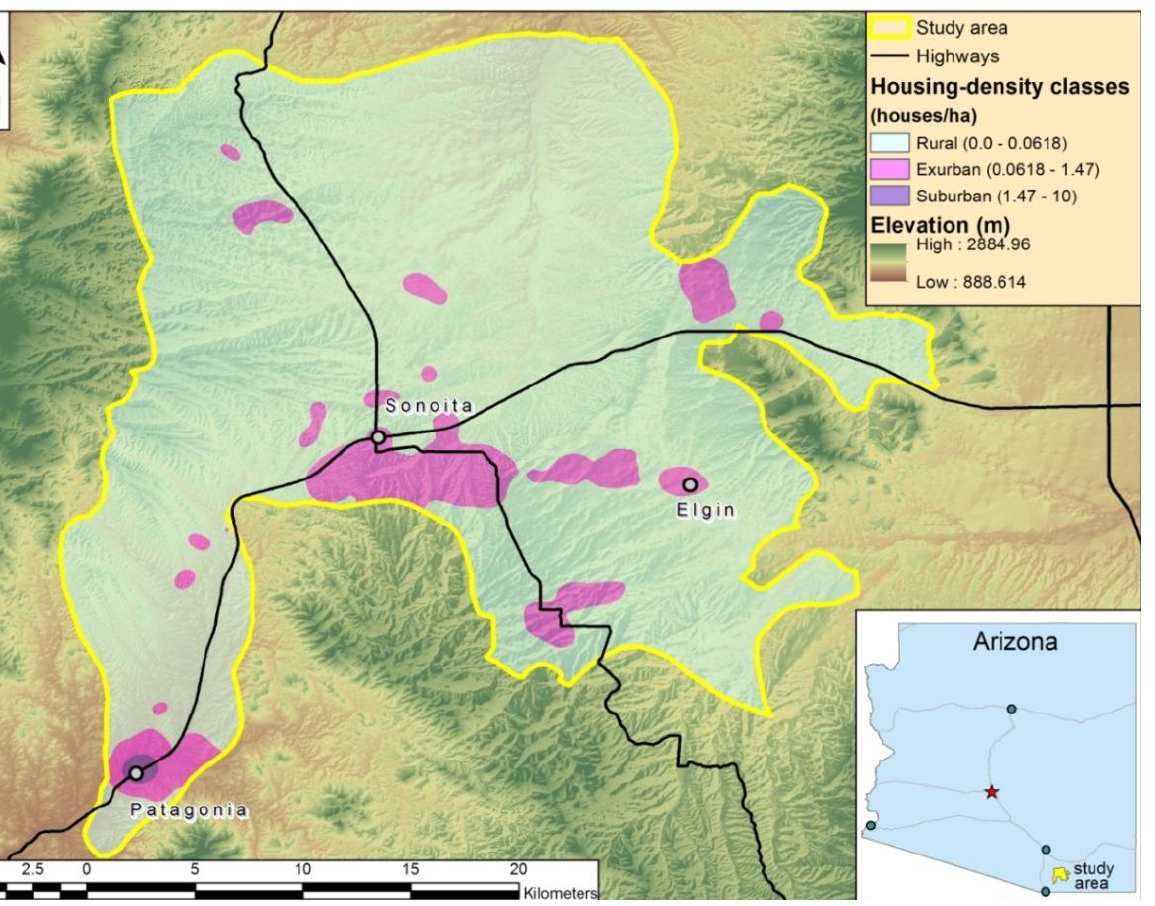
Figure 1. Housing-density classes in the Sonoita Plain, southeastern